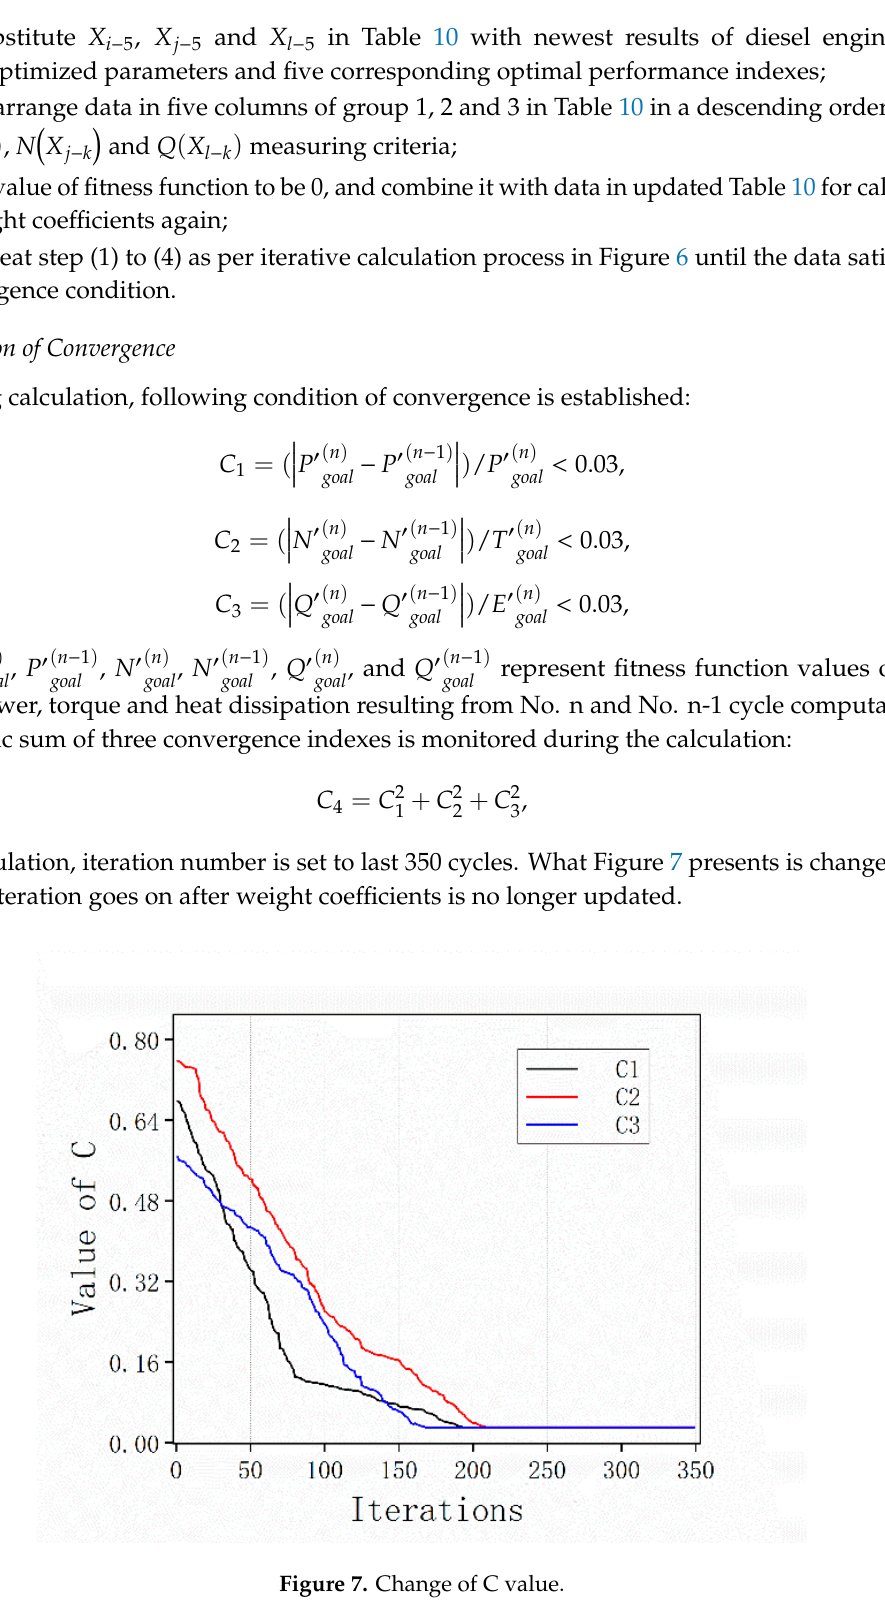
Figure 7. Change of C value.